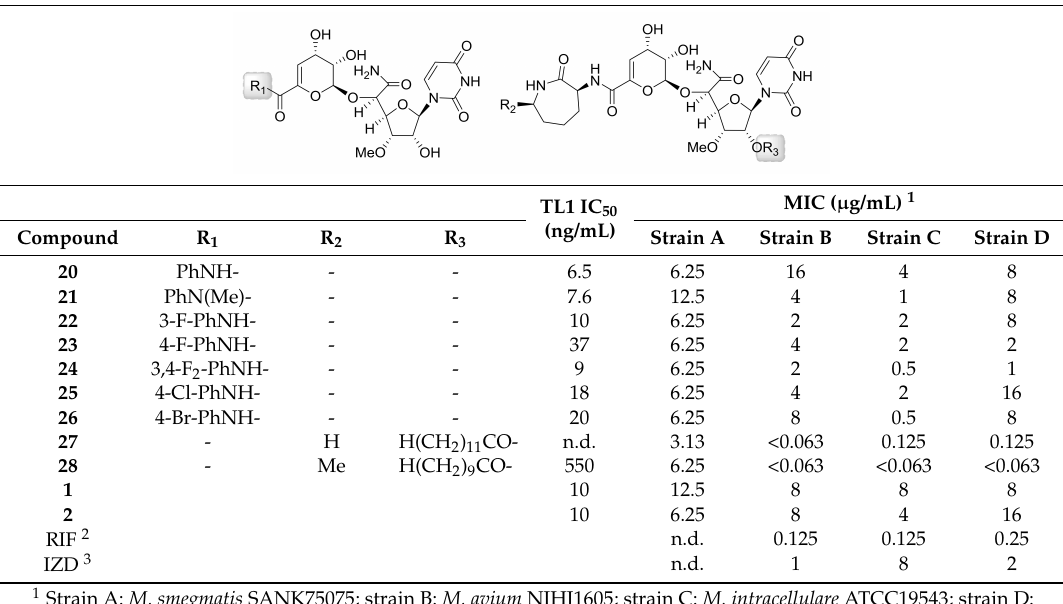
Table 2. Antimycobacterial activities of several capuramycin analogs prepared through